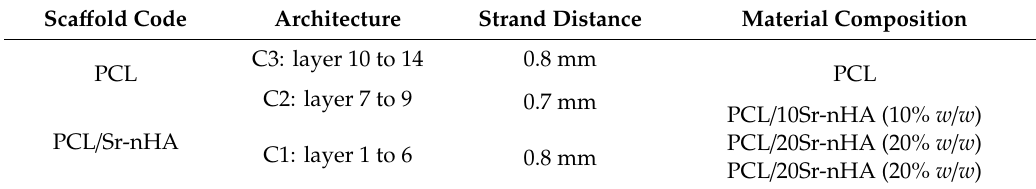
Table 1. 3D sca ff old composition, design parameters and